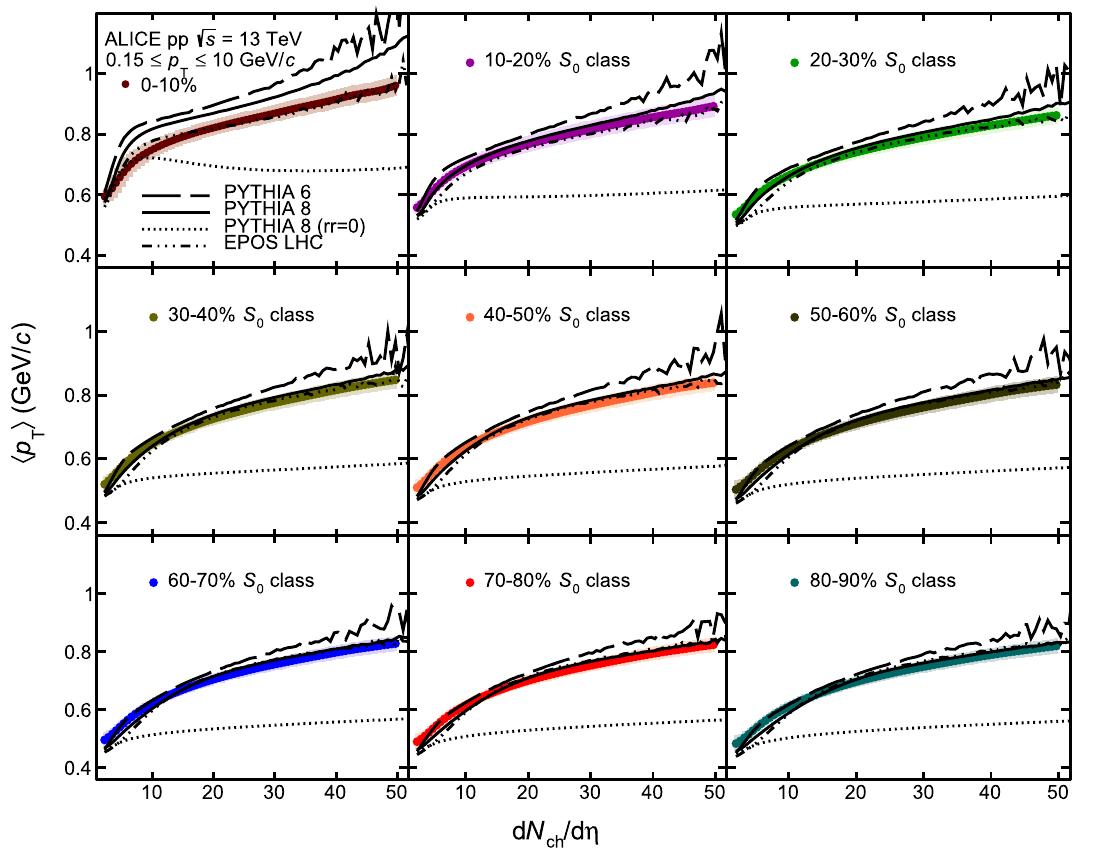
Fig. 10 Average transverse momentum as a function of event dictions. Statistical uncertainties (error bars) are negligible com- √ s = 13TeV. Results for multiplicity in pp collisions at pared to systematic uncertainties (shaded area around the data nine spherocity classes are compared with Monte Carlo pre-